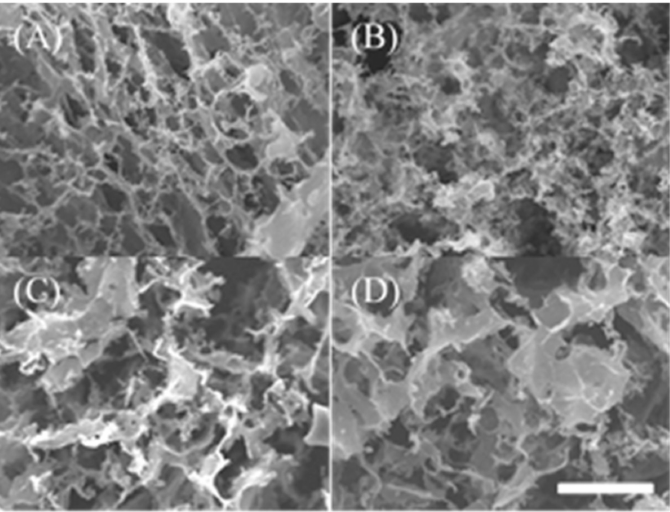
Figure 3. SEM image of 2wt% hydrogel. ( × 2000) (Scale bar: 5 micro m). ( A ) R-Y, ( B ) R-Y-RGDS, ( C ) RGDS-R-Y, ( D )